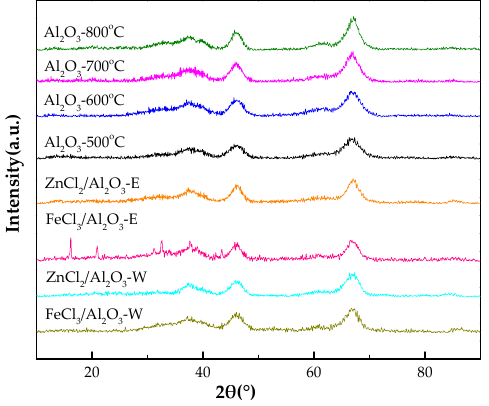
Figure 2. X-ray diffraction patterns of mesoporous alumina and the metal chlorides-modified Figure 2. X ‐ ray diffraction patterns of mesoporous alumina and the metal chlorides ‐ modified mesoporous mesoporous alumina.